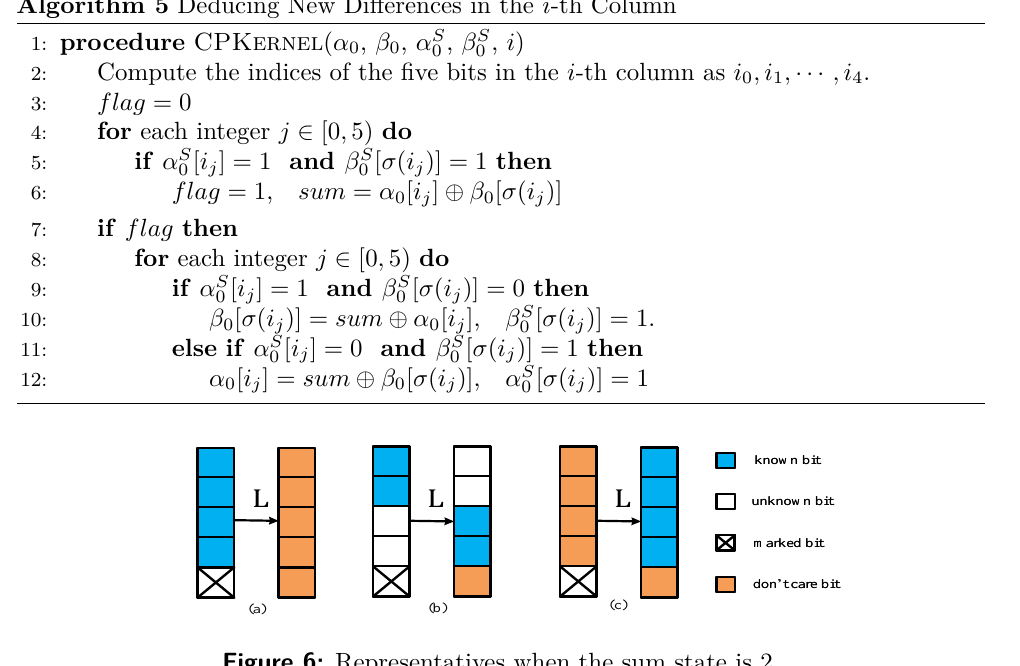
Algorithm 5 Deducing New Differences in the i -th Column